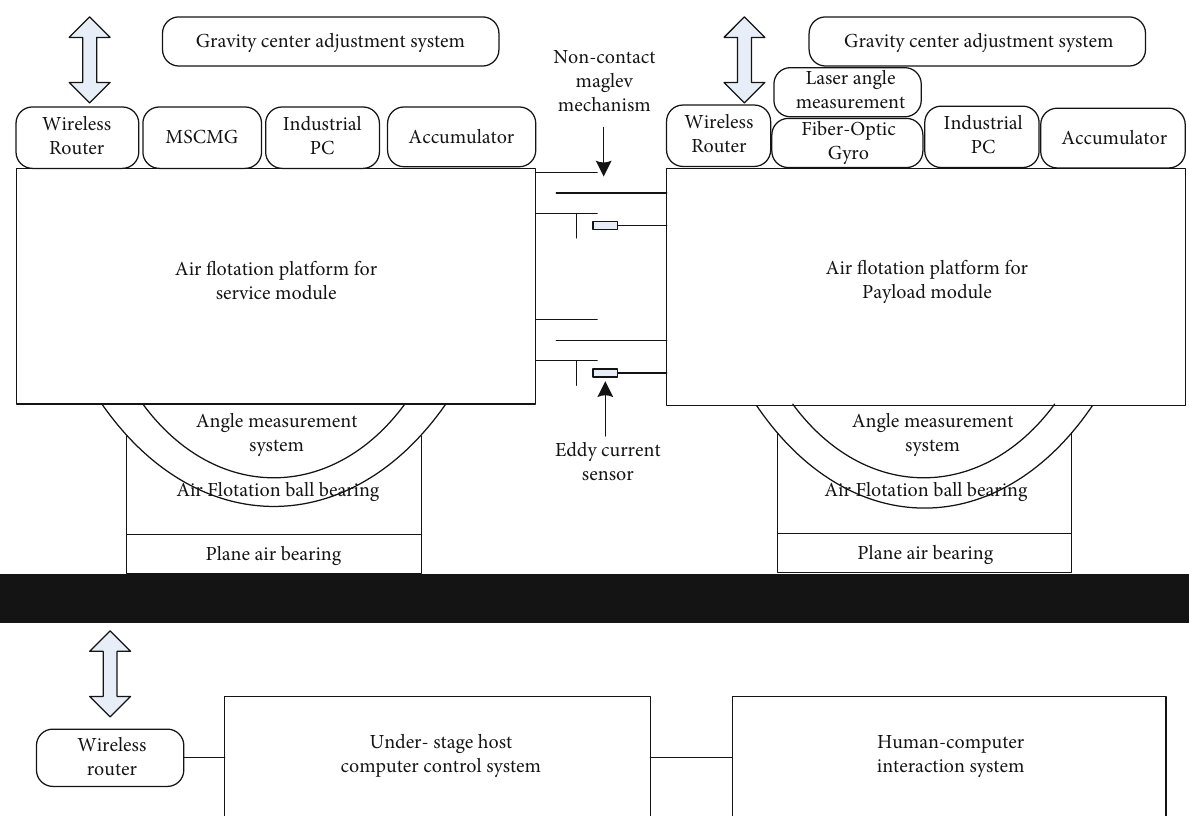
Figure 2: Block diagram of noncontact close-proximity formation satellite control system.